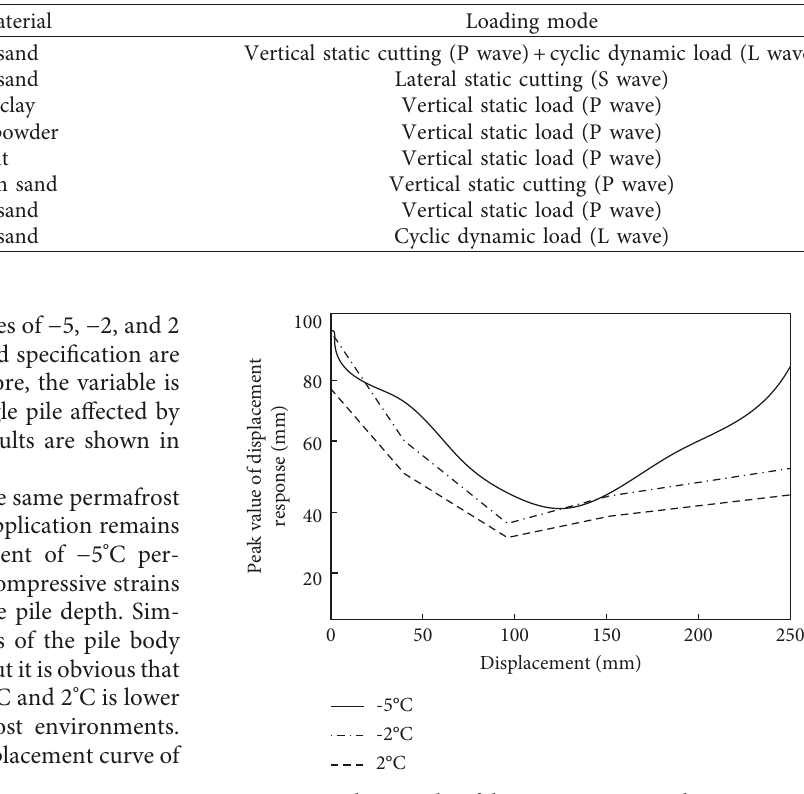
Table 1: Simulation materials and seismic wave loading mode.